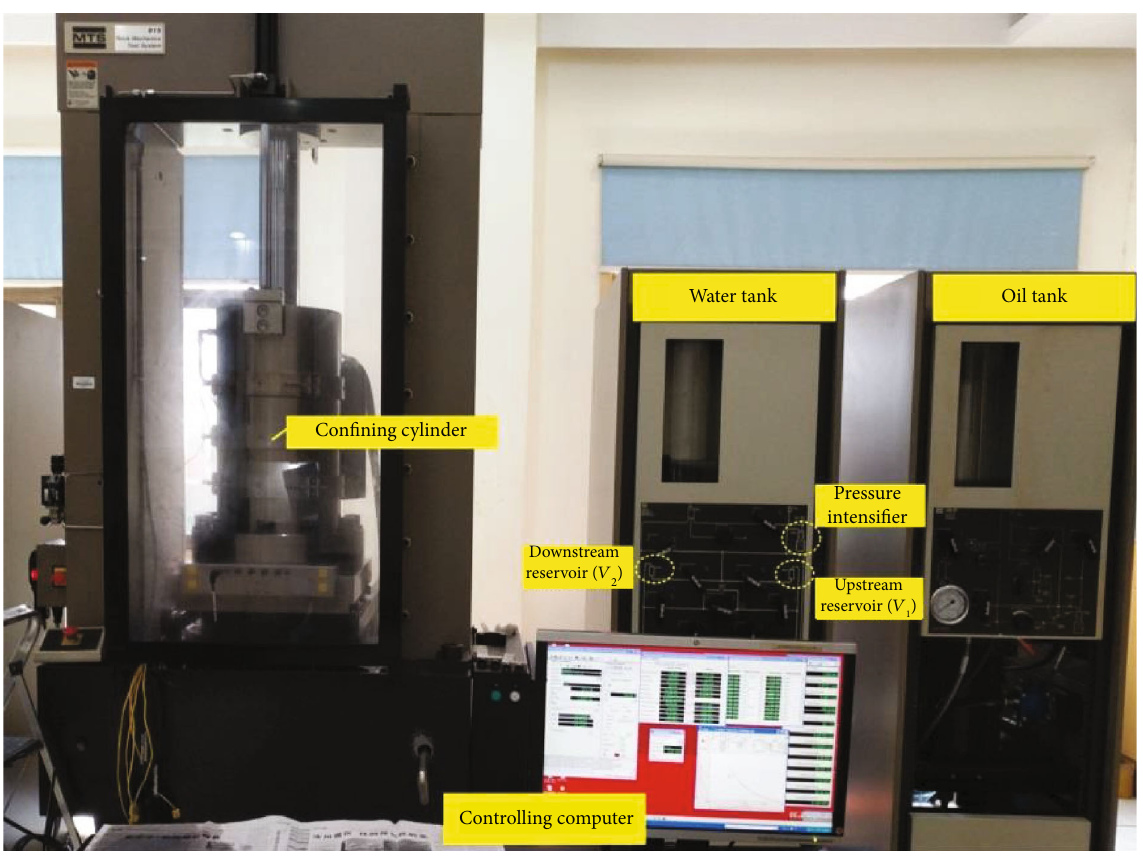
Figure 3: Schematic of transient permeability system.